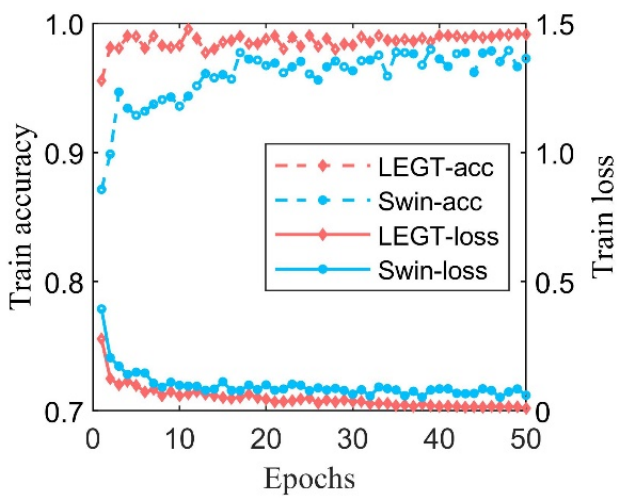
Figure 22. The training process with using LEGT and Swin.